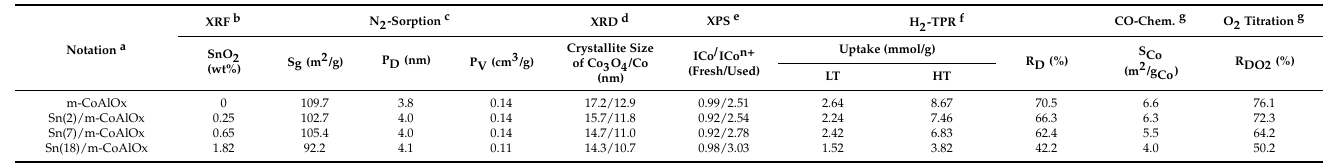
Table 1. Bulk and surface properties of the Sn/m-CoAlOx catalysts such as metal composition, surface area, particle size and